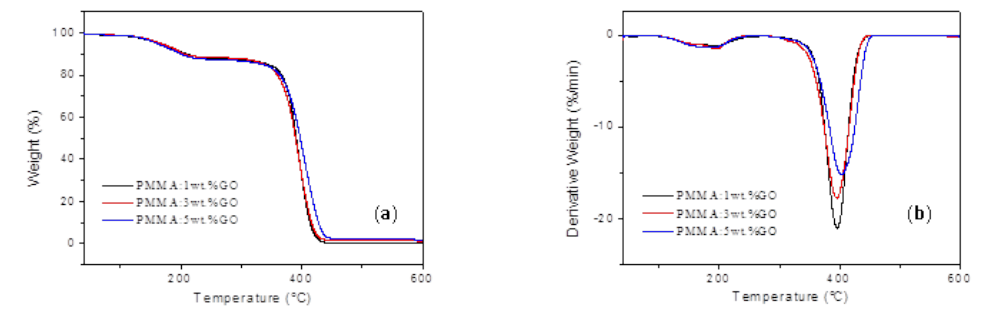
Figure 2. Thermal properties of PMMA: 1 wt % GO, PMMA: 3 wt% GO, and PMMA: 5 wt% GO composite. ( a ) TGA and ( b ) DTG properties of the composites with the content of GO 1 wt %, 3 wt %, and 5 wt %.